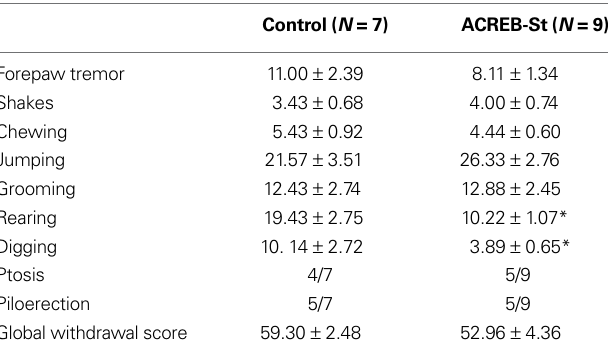
Table 2 | Morphine withdrawal signs in ACREB-St mice and control littermates.